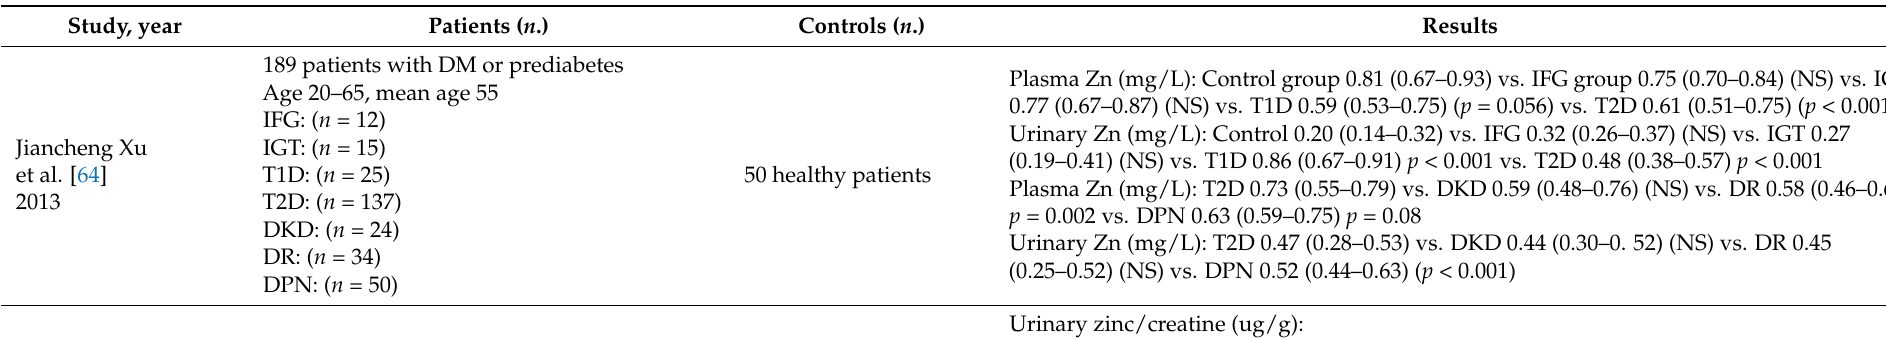
Table 1. Cross-sectional studies analyzing zinc serum levels and renal impairment progression in DKD. Abbreviations: CKD, Chronic kidney disease; Cu, Copper; DKD, Diabetic Kidney Disease; T1D, Type 1 diabetes mellitus; T2D, Type 2 diabetes mellitus; DKD, Diabetic Kidney Disease; DPN, Diabetic peripheral neuropathy;